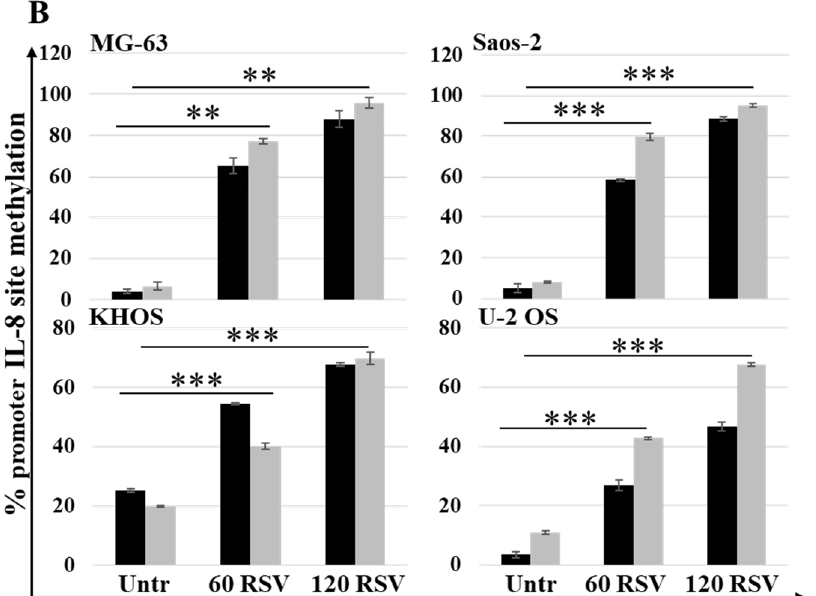
Figure 7. Treatment with RSV induced IL-6 and IL-8 promoter methylation in OS cell lines. MSRE PCR analysis results show the methylation levels of six restriction sites analyzed in 3 regions of the IL-6 promoter ( A ) and the methylation levels of two restriction sites analyzed in 2 regions of the IL-8 promoter ( B ). Data are reported as mean ± SD of n = 4 triplicates. A one-way ANOVA test was used to evaluate the effect of the RSV treatment factor (60 and 120 µ M) on restriction sites methylation in OS cell lines. Dunnett’s test: *, p < 0.05, **, p < 0.005, ***, p < 0.0005 versus untreated cell culture.